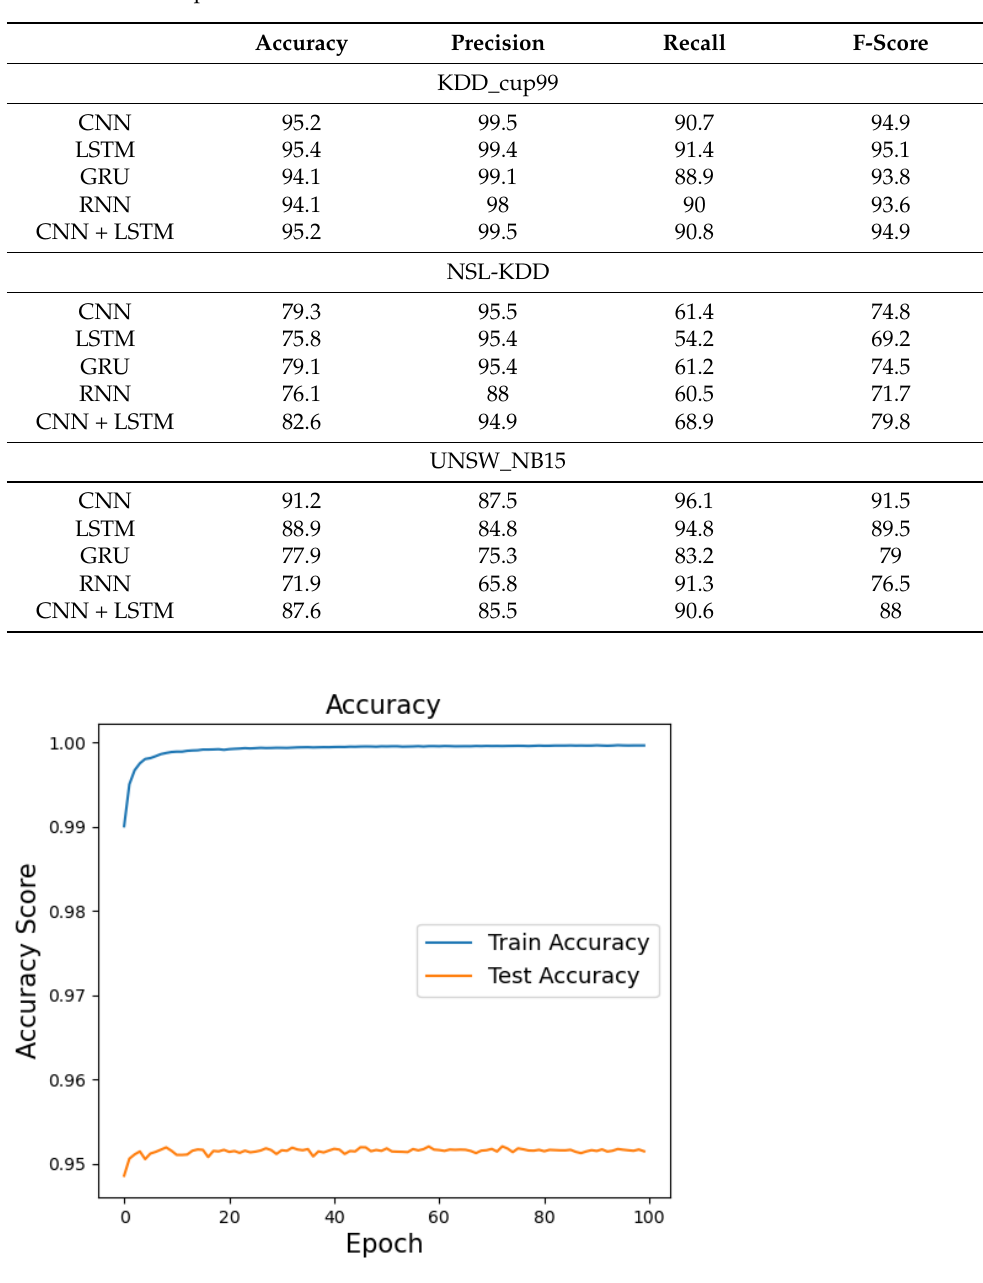
Figure 4. Training and Testing accuracy of CNN on KDD_cup99